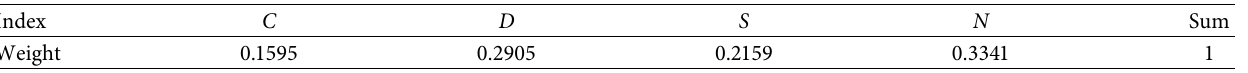
Figure 14: Improvement ratios of the left-turning time at the east entrance. (a) Scheme 1. (b) Scheme 2. (c) Scheme 3. (d) Scheme 4. (e) Scheme 5. E-W volume means the same traffic volume of east entrance and west entrance. N-S volume means the same traffic volume of north entrance and south entrance. Table 8: Weights of the four